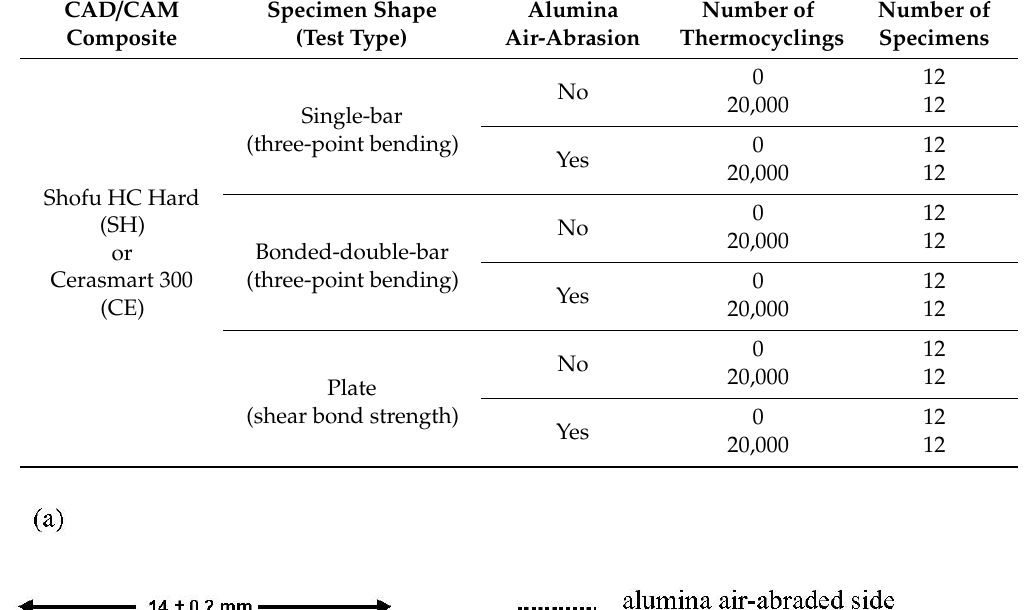
Table 2. Alumina air-abrasion and thermocycling for the groups used in each test.